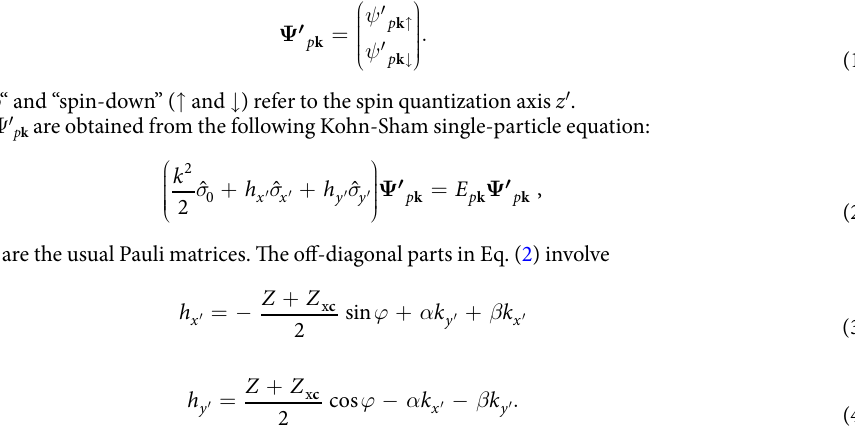
Figure 1 defines two reference frames. The primed frame ′  is fixed with respect to the quantum well: the x ′ -, y ′ - and z ′ -axes point along the crystallographic [100], [010], and [001] directions, respectively; the 2DEG is in the x ′ − y ′ plane. The Rashba and Dresselhaus SOC fields will be introduced in  ′ , but it will be convenient for the discussion of spin waves to work in a coordinate system  which is oriented such that its x and z axes lie in the quantum well plane, and the z -axis points along the in-plane magnetic field B . As shown in Fig. 1, the x -axis is at an angle ϕ with respect to the x ′ -axis. Single-particle states.